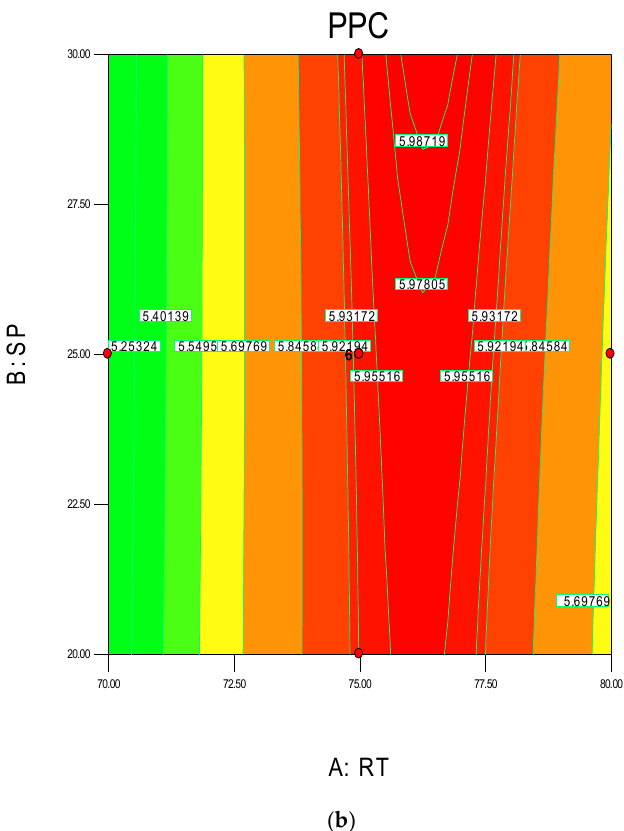
Figure 3. 3D response surface ( a ) with 2D contour plot ( b ) of reaction temperature (RT) and system pressure (SP).